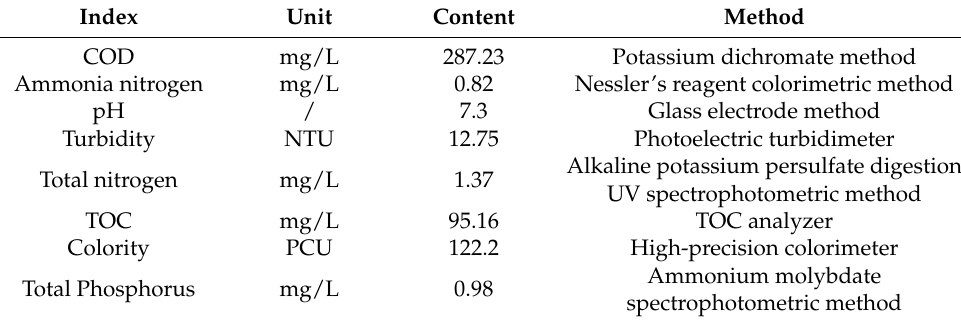
Table 1. Water quality analysis of experimental